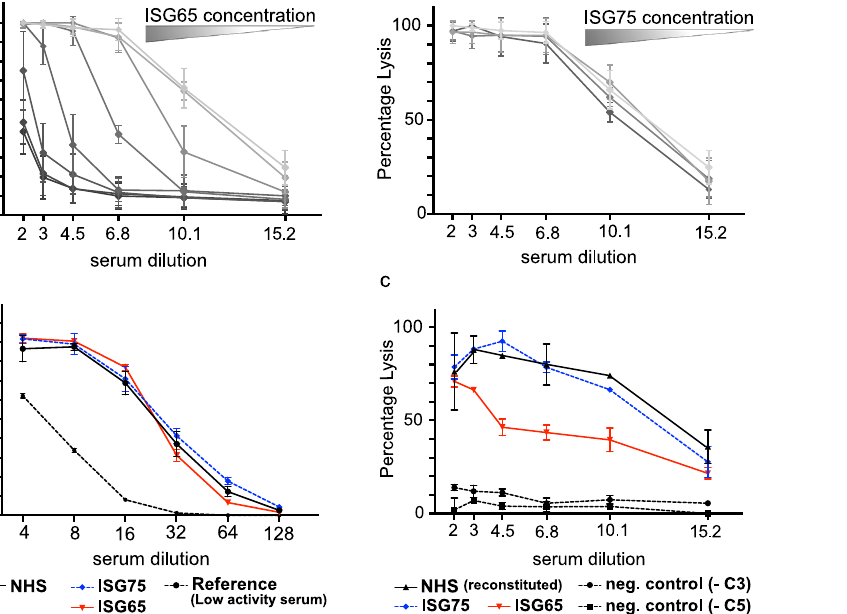
ISG75 showed notable inhibition of erythrocyte lysis. Low complement activity reference( n =3technicalreplicates;datapointsarepresentedasmeanvalues±SD) isdepictedwithadashedblackline. c AdaptedAP50haemolysisassayusingC5-and C3-depleted human sera. Binding of ISG65 to assembled AP C5 convertase C3bBbC3b reduced haemolysis (red solid line). No reduction in haemolysis could bedetectedforISG75(dashedblueline).HumanseradepletedforeitherC5(-C5)or C3 (-C3) did not cause haemolysis (dashed black lines). Incubation of erythrocytes with C5-depleted serum followed by incubation with C3-depleted serum, recon- stituted haemolytic activity (NHS (reconstituted), solid back line). ( n =3 technical replicates; data points are presented as mean values±SD). Source data are pro- vided as a Source Data fi